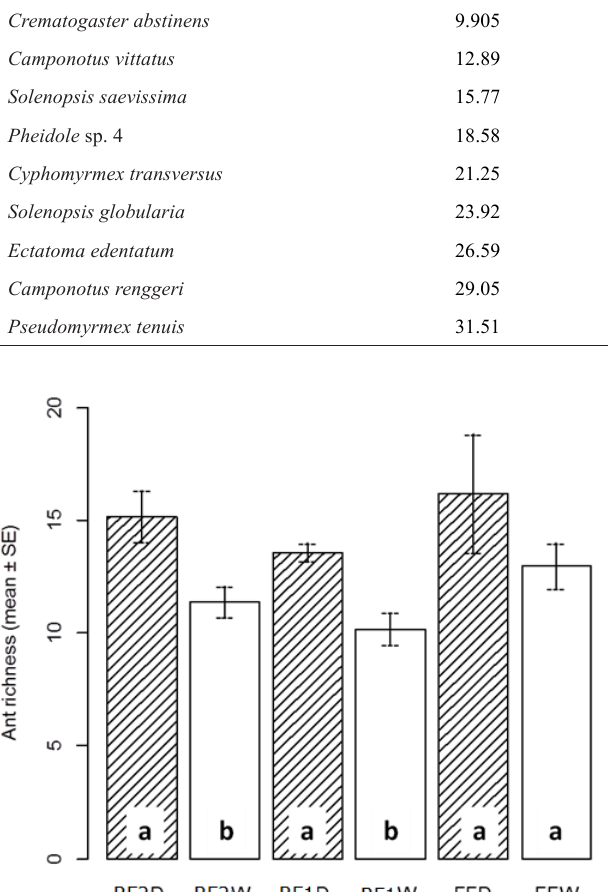
Figure 1. Species richness of ants in the dry season (white bars) and rainy season (hatched bars) (mean ± SE) sampled in three areas with different stages of forest recovery. RF1 = Fragment with 7 years of reforestation; RF2 = Fragment of 5 years of reforestation and FF = forest fragment with 35 years of plant recovery (D and W indicate sampling in dry and wet seasons, respectively). Different letters on bars indicate significant difference within the same site (p <